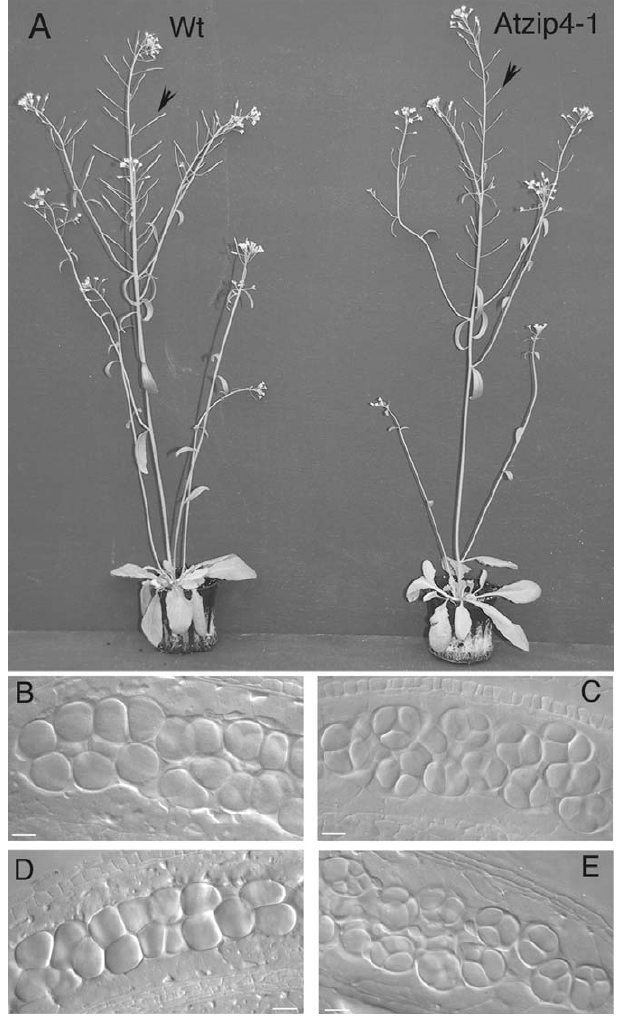
Figure 2. Atzip4 Mutant Phenotype (A) Comparison of wild-type and homozygous Atzip4-1 mutant plants after 30 d in the greenhouse. Arrows show siliques that elongate in wild type but not in mutant. (B–E) Male sporogenesis in wild type (B–C) and Atzip4 mutant (D–E) shown for Atzip4-1. Male meiocytes (PMCs) are shown in (B and D) within the anthers, and the product of meiosis (tetrads or polyads) is shown in (C and E). Wt, wild type.